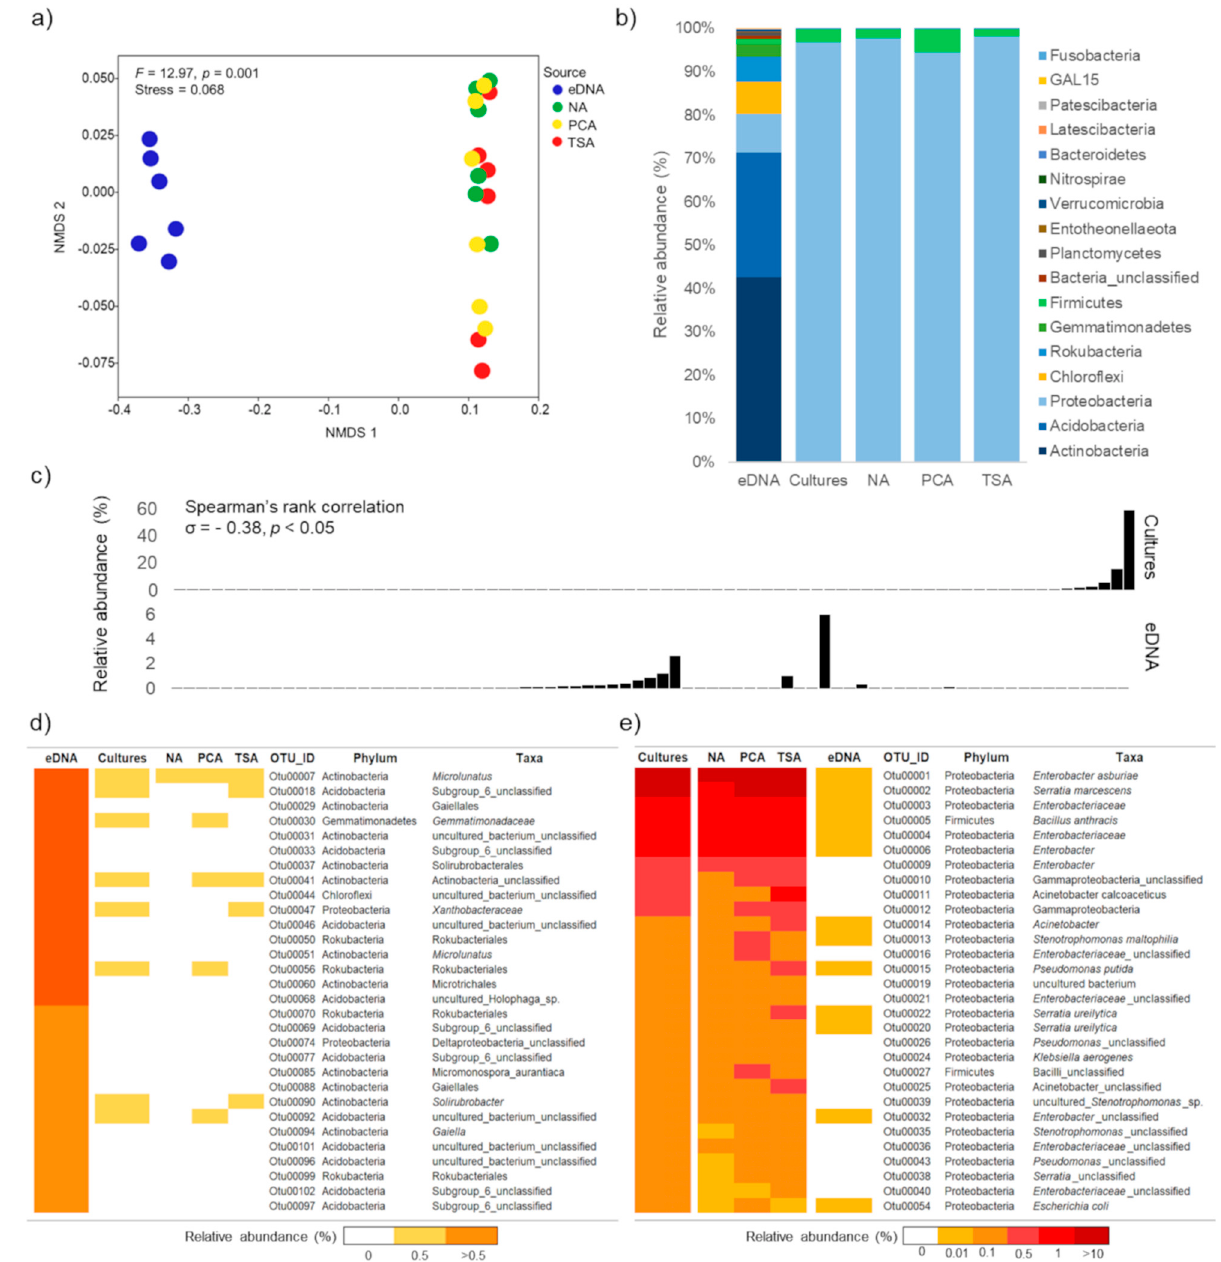
Figure 3. Taxonomic distribution of soil bacteria detected by eDNA- and culture-based amplicon sequencing. ( a ) Non-metric multidimensional scaling (NMDS) ordination of bacterial communities based on Bray-Curtis distance measure, under four different treatments. ( b ) Proportion of bacterial phyla detected in each treatment. ( c ) Spearman’s rank correlation between relative abundance of shared OTUs derived from eDNA and enrichment cultures. Bar plots show relative abundance of shared OTUs. A plot at the same position (x-axis) represents an identical OTU. Plots on baseline (nearly zero) represent OTUs with relative abundance lower than 0.05%. ( d ) Heat map of most abundance OTUs (top 30) based on eDNA method and ( e ) enrichment cultures. Color indicates relative abundance. Darker red represents high relative abundance and white represents non-detected OTUs. Column represents method and type of culture medium. The abbreviations for indicated treatments were as follows: eDNA = eDNA-based methods, cultures = enrichment culture-based method, which is a result from three media: NA = nutrient agar; PCA = plate count agar; and TSA = tryptone soy agar.